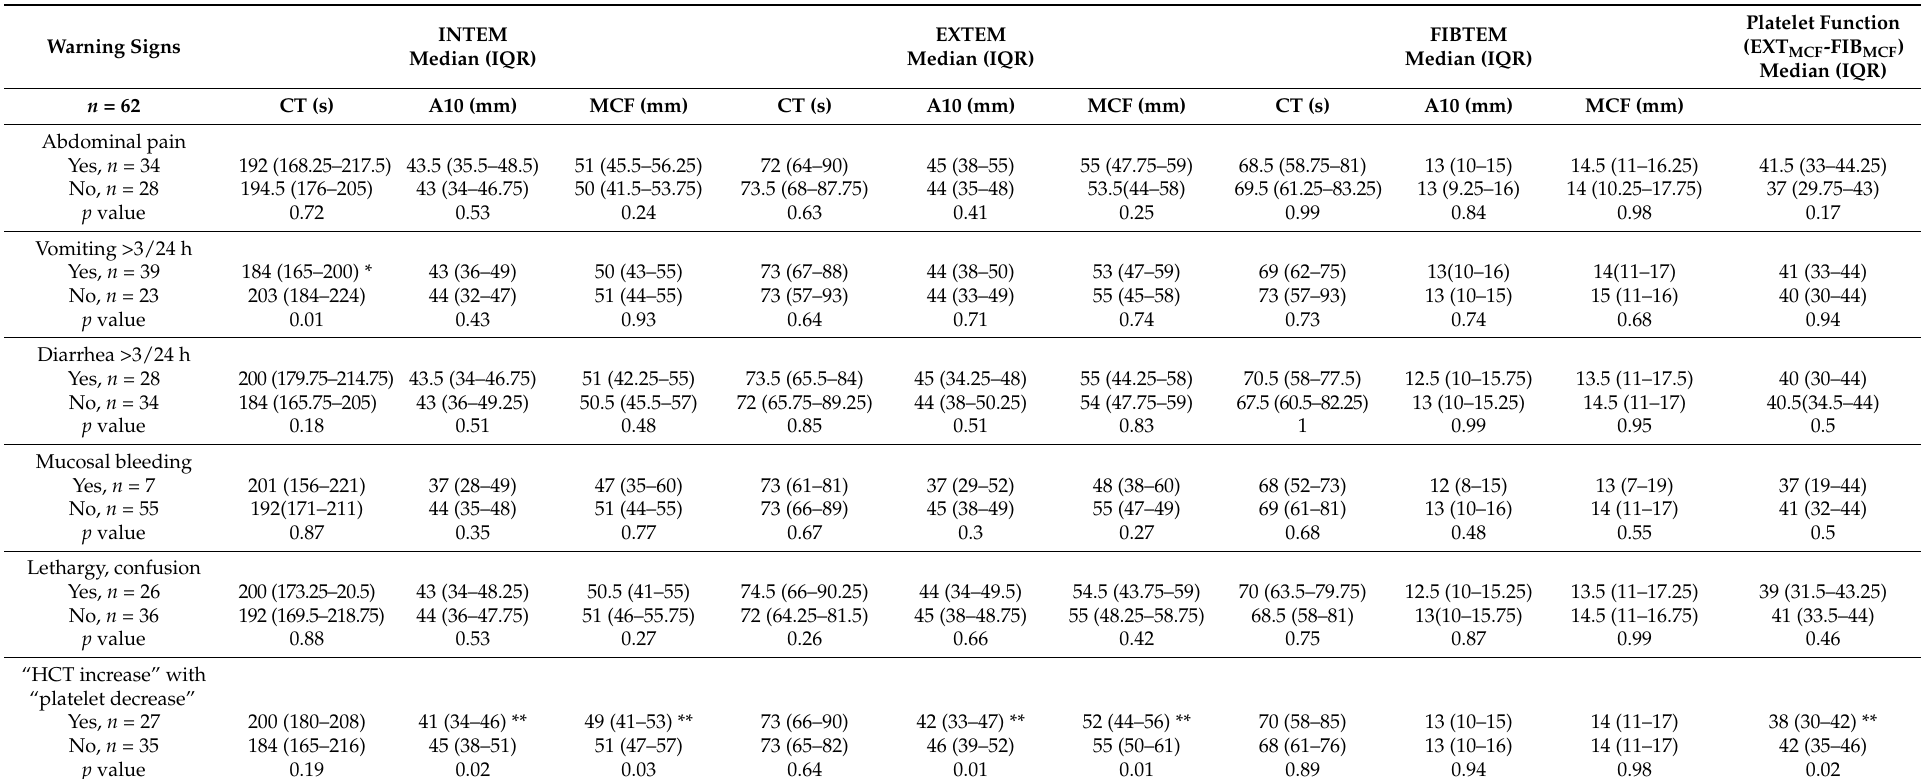
Table 3. Association of warning signs in febrile phase with ROTEM